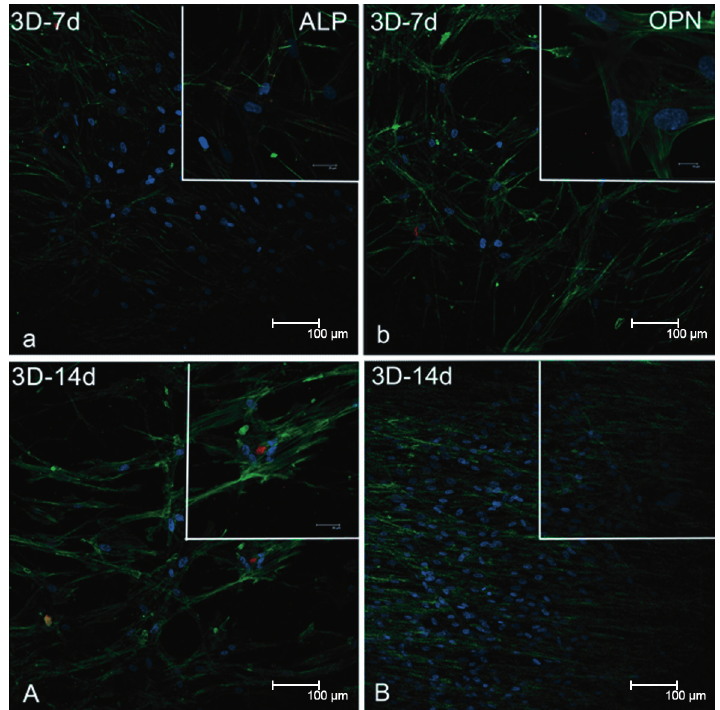
Figure 4- hPDLF cells grown on three-dimensional surface (3D) at 7 days (a and b) and 14 days (A and B). Fluorescence of actin cytoskeleton labeling (phalloidin labeling, green fluorescence), DNA stain (DAPI, blue fluorescence), alkaline phosphatase (ALP) (a and A) and osteopontin (OPN) (b and B) red fluorescence observed in confocal